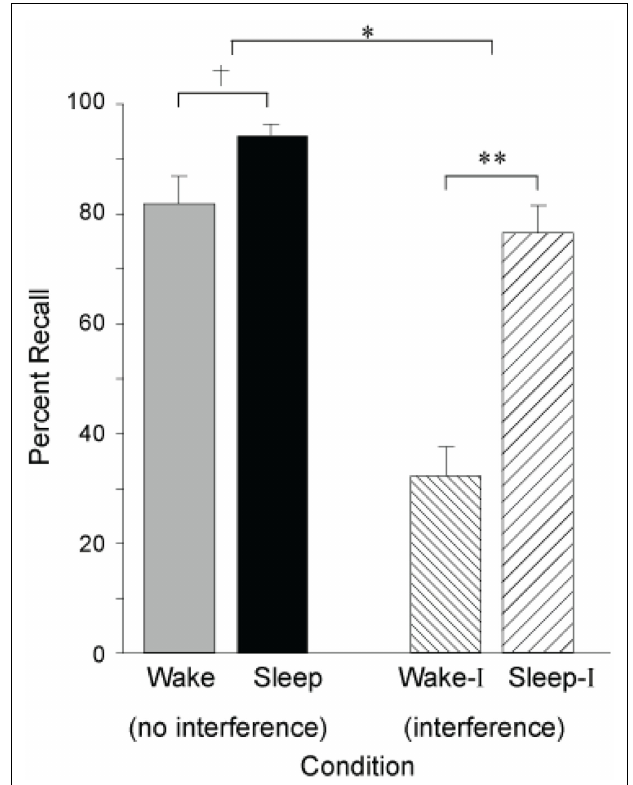
FIGURE 4 | Impact of sleep on the consolidation and stabilization of declarative memory. Percent correct recall for B words from the original A–B pair after a 12h retention interval of either wake or sleep following no interference or interference learning (list A–C). † p < 0.10, * p < 0.05, ** p < 0.001; error bars indicate S.E.M. Modified from Ellenbogen et al.